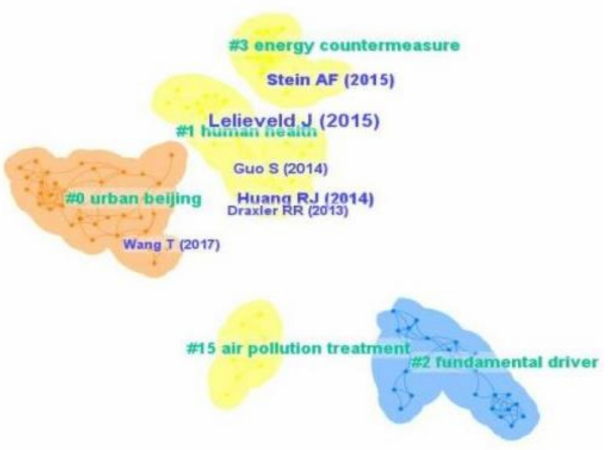
Figure 2. Co-citation map of air pollution governance for the period 2000 to 2021.